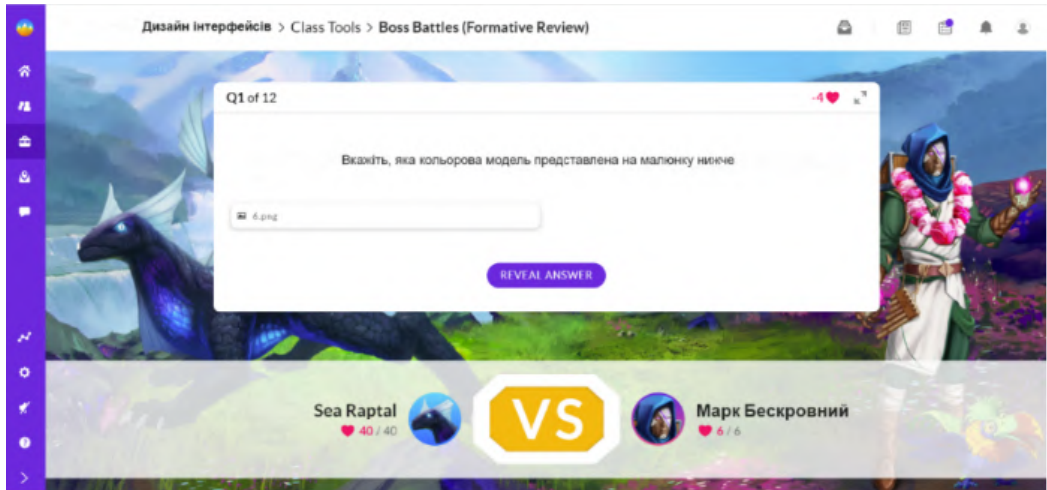
Figure 2: The episode of the Boss Battles test solving in Classcraft environment in the course of interface design